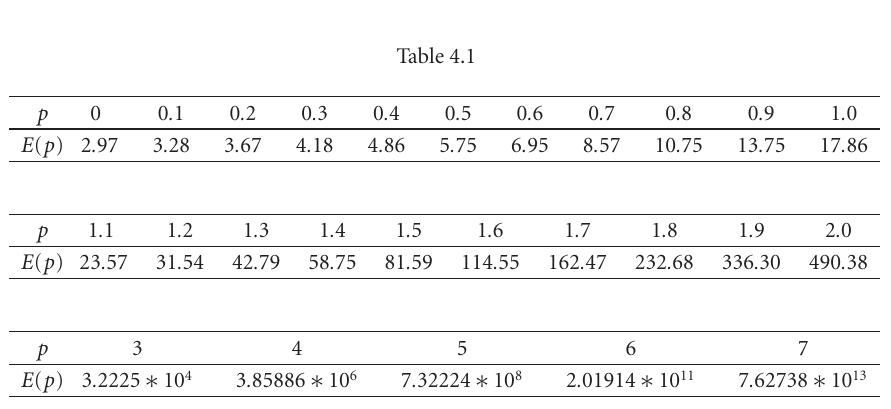
. = . = 3, α 0 4 . 0 × 10 − 8 (by formula